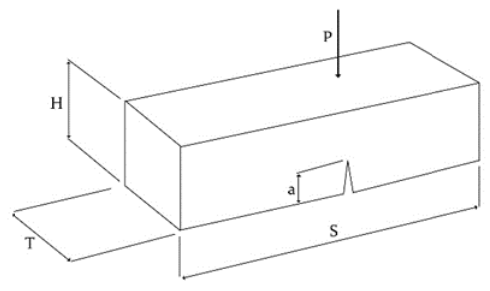
Figure 2. The geometry of the tested specimen [28].